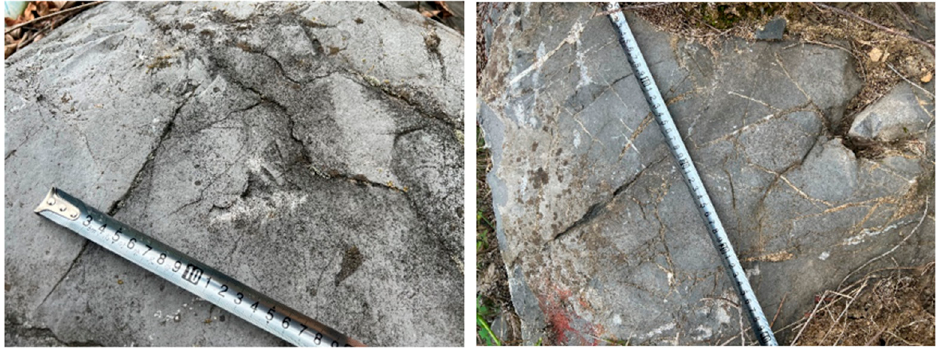
Figure 4. The photos for outcrop fractures. Table 3. Calculation of water flow in typical fracture gap widths of Groups I and II.